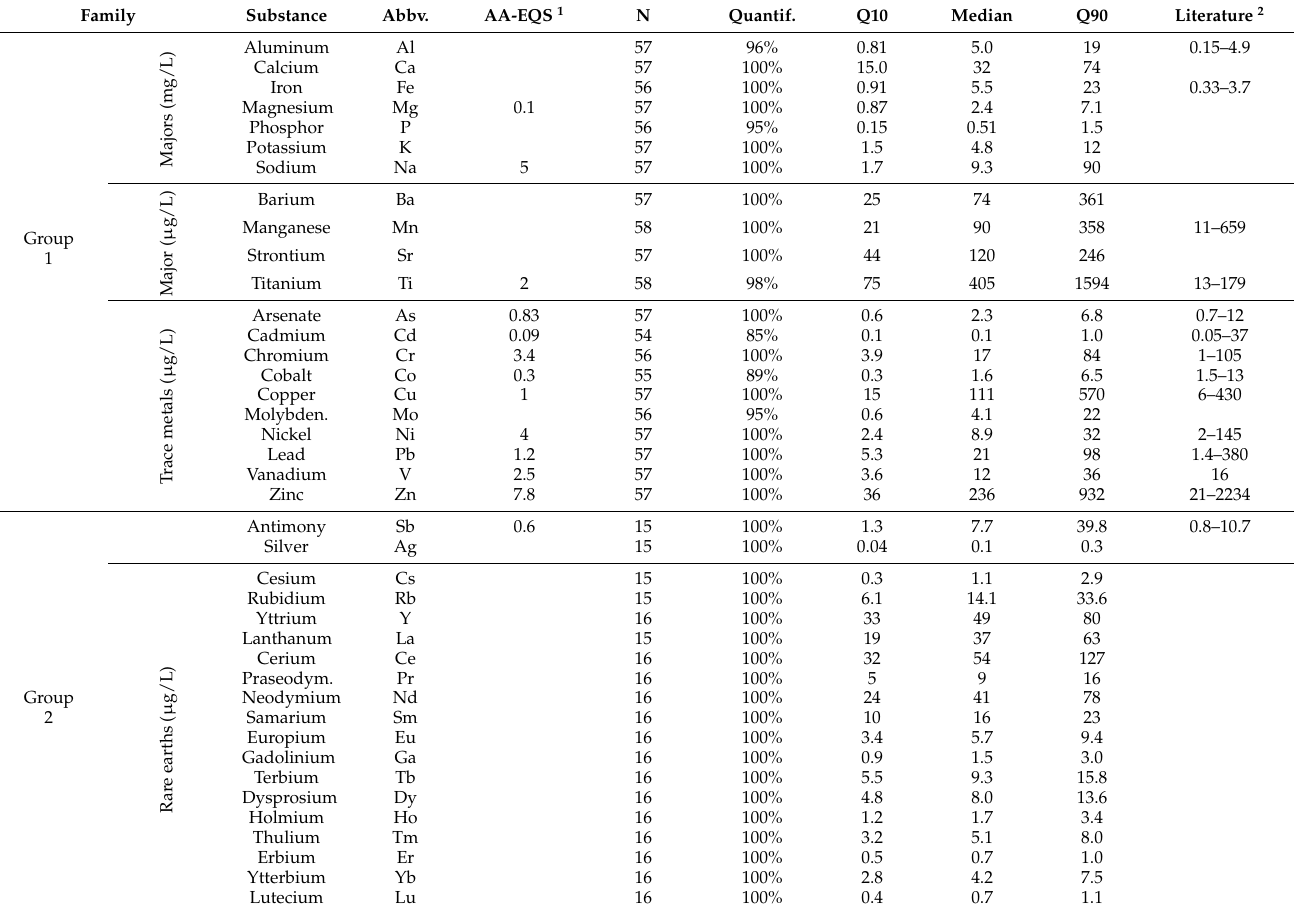
Table 5. Inorganic elements analyzed in the runoff; environmental quality standards (EQS); quantifi- cation frequency and range of quantified total EMC concentrations (first decile Q 10 , median and last decile Q 90 ) over the 4 study sites.